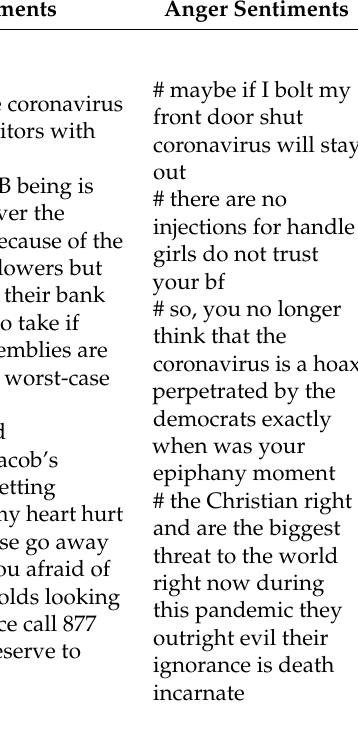
Table 1. Sample tweets that express sadness, joy, fear, and anger sentiments on COVID-19. Sad